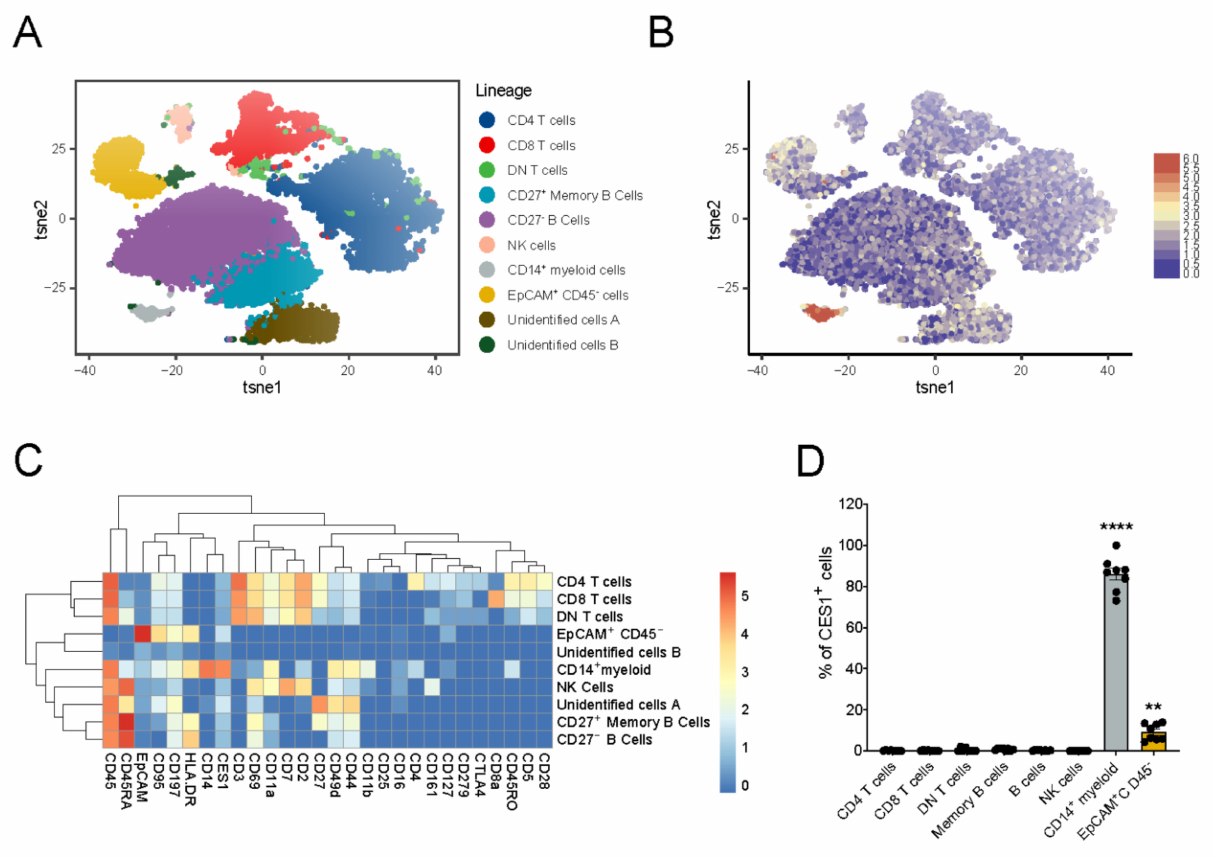
Figure 1. Immunophenotyping of IBD intestinal biopsies reveals specific CES1 expression in CD14 + myeloid cells population. ( A ) Intestinal biopsies were collected from 6 IBD patients. In total, 8 biopsies were collected (non-inflamed biopsies, n = 2, inflamed biopsies, n = 6, two pairs of non-inflamed and inflamed biopsies from the same patients, n = 2). Cells from intestinal biopsies of 6 IBD patients were barcoded, stained, and pooled for CyTOF and visualized in a tSNE plot after mass cytometry analysis. B cells, CD4 T cells, CD8 T cells, DN T cells, CD14 + myeloid cells, EpCAM + cells, and NK cells were identified. ( B ) CES1 expression intensity was demonstrated among identified cell clusters in ( A ). ( C ) A heat map shows expression intensity of different (lineage) markers in relation to the identified cell clusters in ( A ). ( D ) Percentages of CES1 + cells among identified cell subsets are shown. Data are represented as mean with SEM of 8 samples; CD14 + myeloid cells, and EpCAM + CD45 − cells were compared to the rest, Statistical testing was performed using a one-way ANOVA test; ** p ≤ 0.01, **** p ≤ 0.0001; SEM, standard error of the